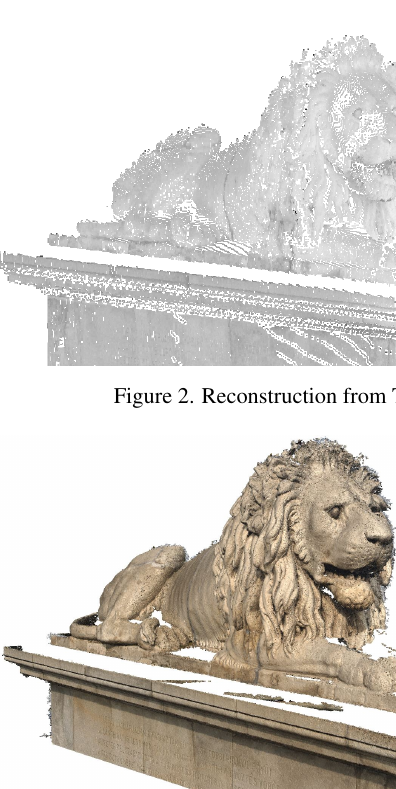
Figure 3. Reconstruction from DSLR camera images